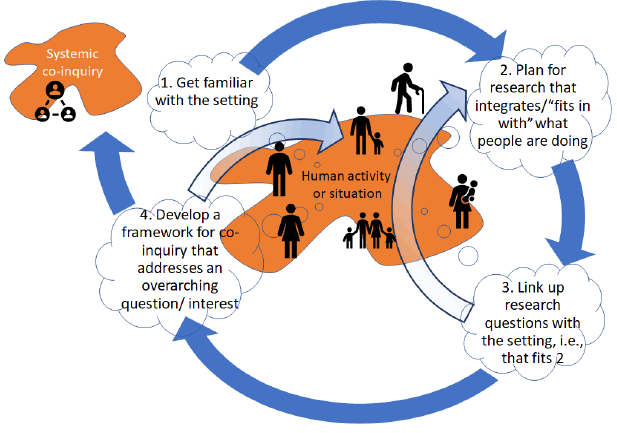
Fig. 2 . Steps for developing co-inquiry with feedback loops, leading to systemic co-inquiry.